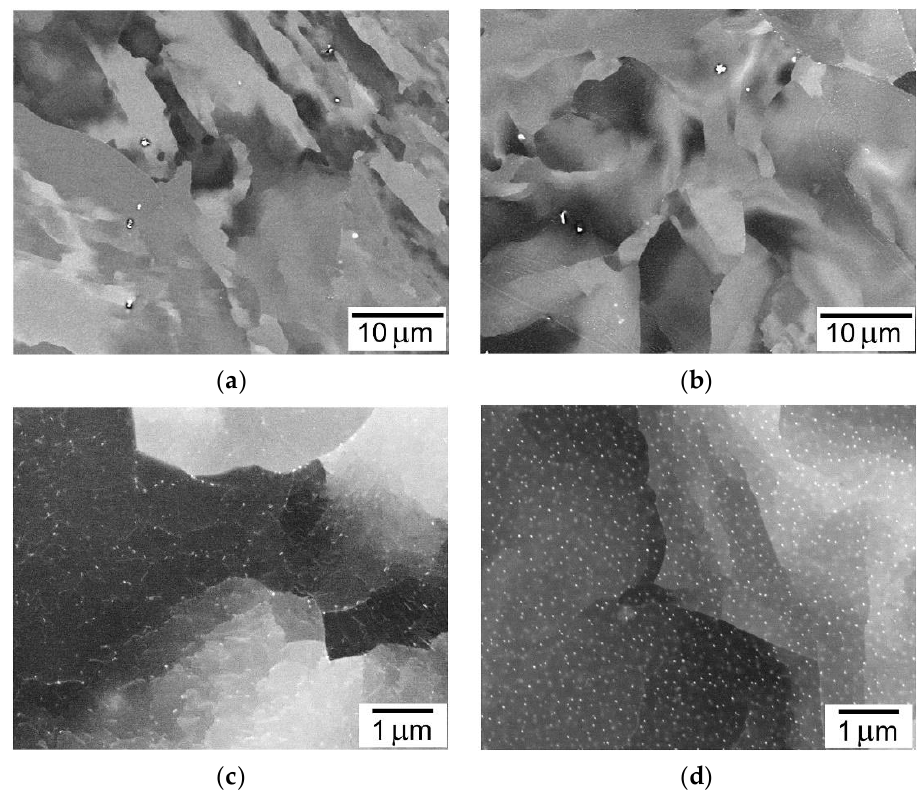
Figure 7. BSE images taken from gauge portions of the creep-interrupted alloys at 240 h under the creep condition of 650 °C/60 MPa at low ( a , b ) and high ( c , d ) magnifications: ( a , c ) 0.09 Hf alloy, ( b , d ) 0.33 Hf alloy. Fine particles observed in ( c , d ) are Fe 2 Hf Laves phase. Relatively coarse particles observed in ( a , b ) are Hf containing carbide/carbonitride.